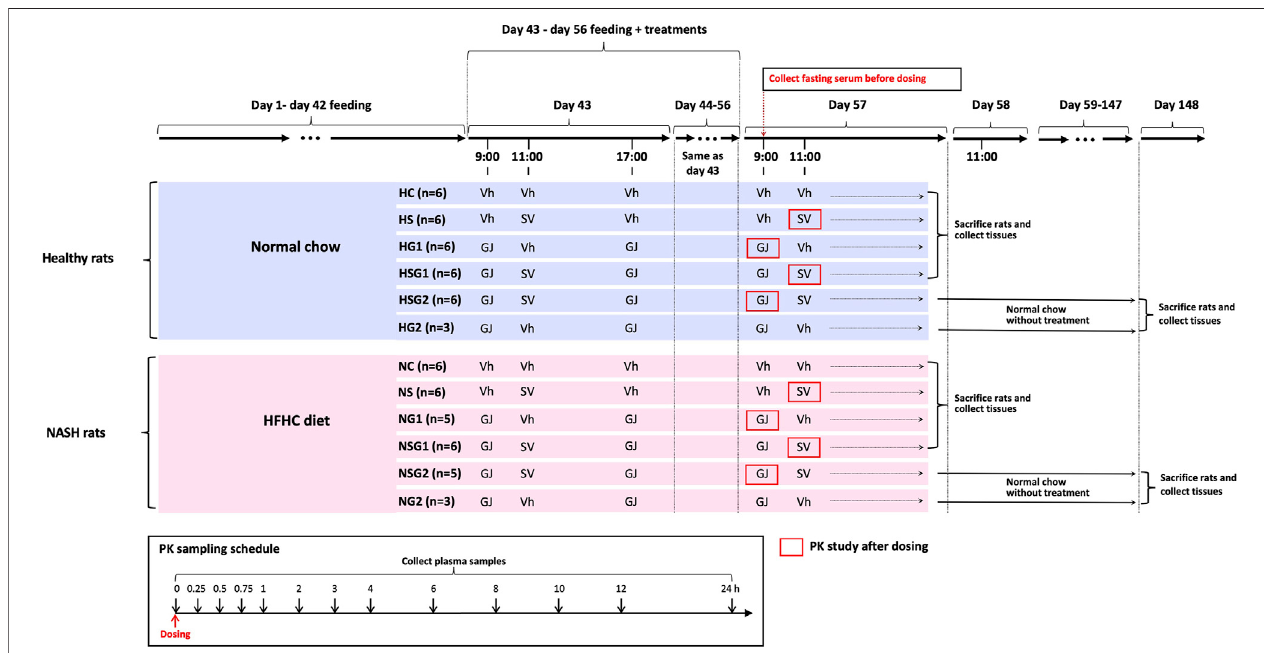
FIGURE 2 | Animal grouping, dosing, and sample collections for the investigations of pharmacokinetic and pharmacodynamic interactions between SV (8.66 mg/kg,p.o.) andGJ(325 mg/kg, p.o.).HFHC,high-fathigh-cholesterol;Vh,vehicle.HandNdenoted healthyand NASH,respectively.C,S,andGindicatedthat the rats received vehicle, SV, and GJ,